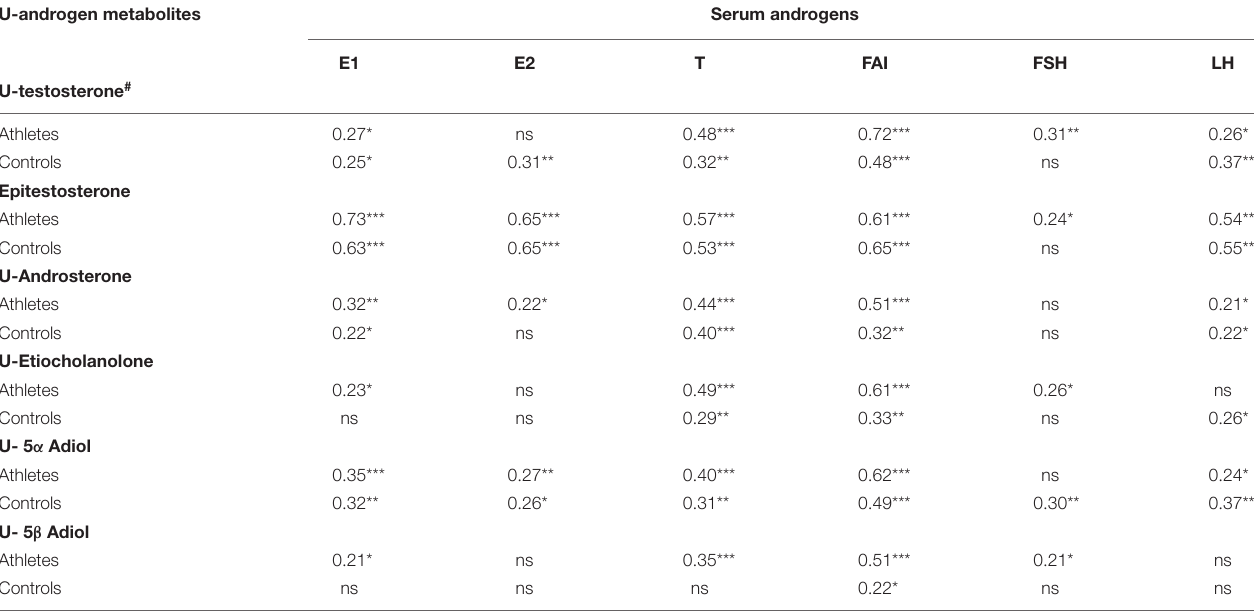
TABLE 2 | Correlation matrix between serum androgens and urinary androgen metabolites in female Olympic athletes ( n = 94) and controls ( n = 86). U-androgen